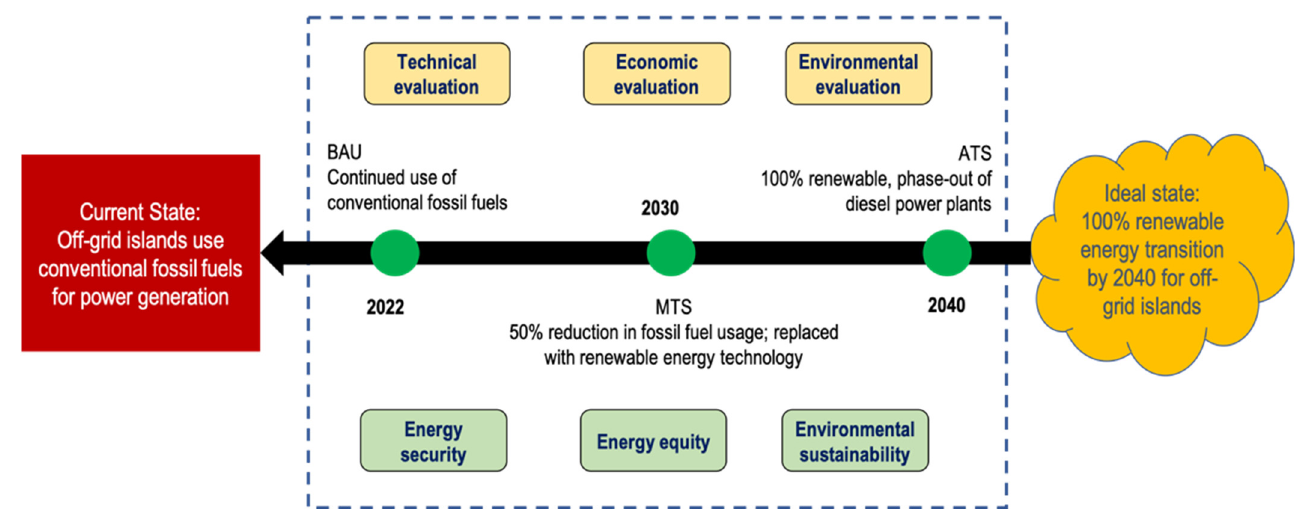
Figure 2. Research